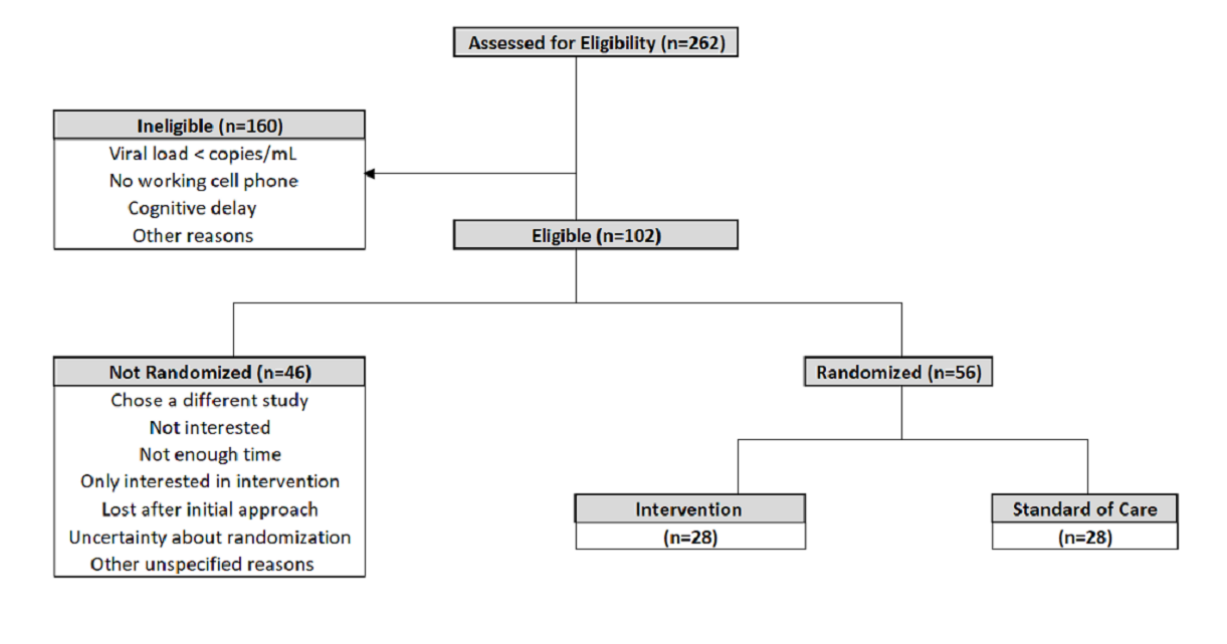
Figure 2. Recruitment of Study